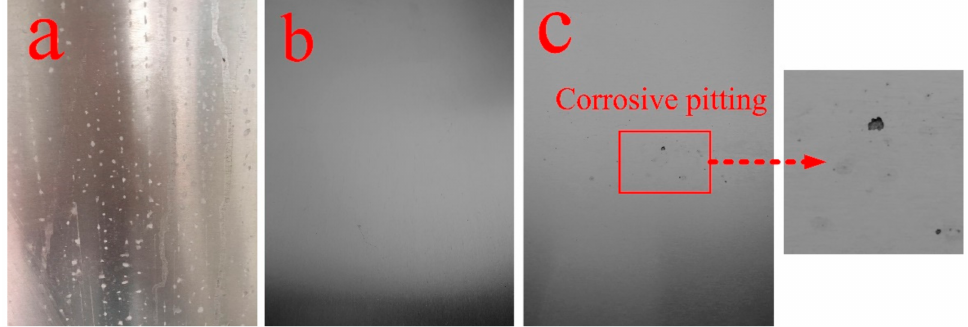
Figure 13. Surface conditions of normal and anodized aluminum regenerator after experiments. ( a ) Corrosion on normal Al; ( b ) Surface condition after regeneration experiments of anodized Al; ( c ) Pitting corrosion on anodized Al under high solution temperature.